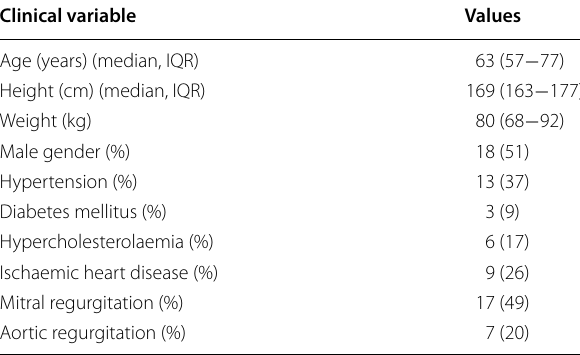
Table 2 Patient characteristics ( n